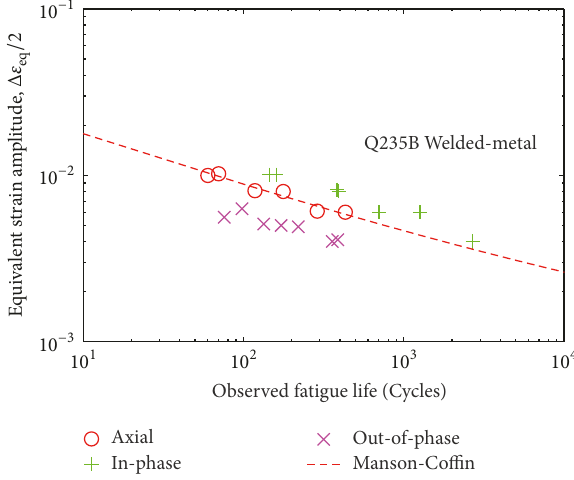
Figure 18: Correlation of the equivalent strain parameters versus fatigue